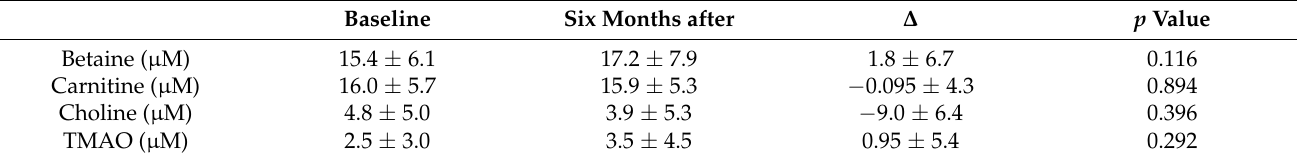
Table 3. Serum metabolites at baseline and six months after bariatric